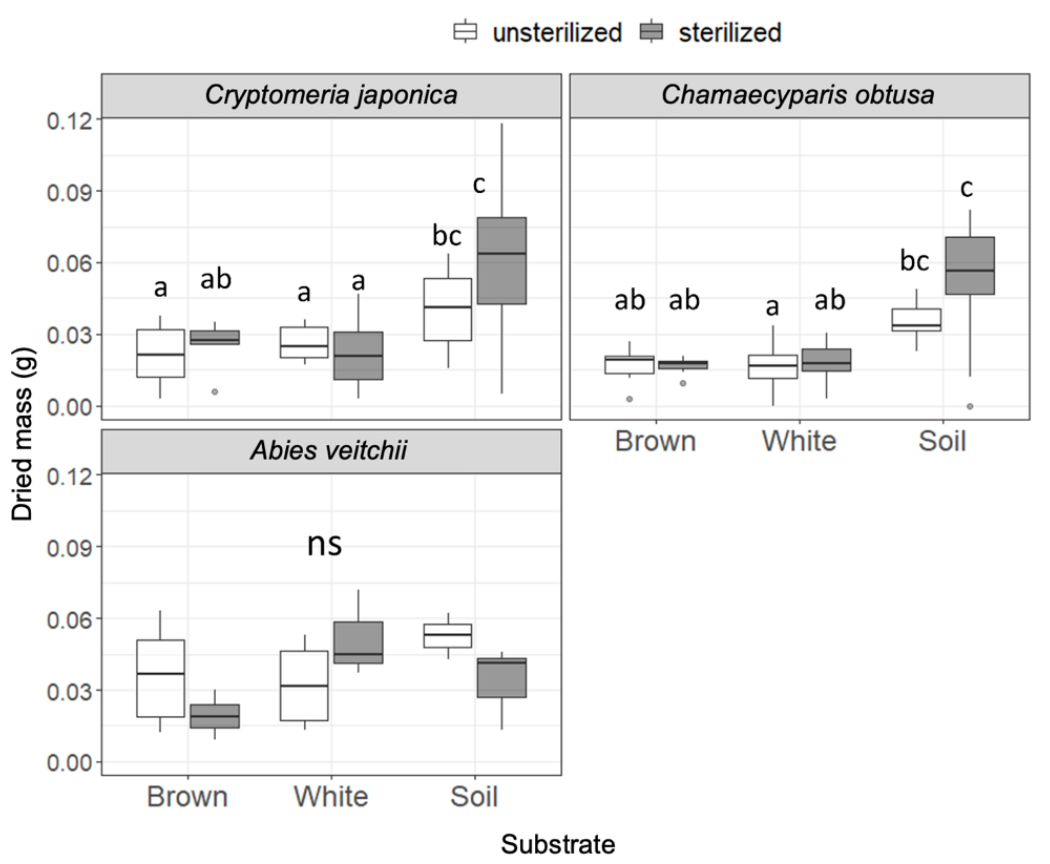
Figure 3. Seedling dry mass of the three tree species after incubation on unsterilized and sterilized substrates (brown rot wood, white rot wood, and soil). Box plots display median, 95% confidence interval, and the minimum and maximum values and points outside the box represent outliers. Dif- ferent letters indicate significant differences among the six substrates ( p < 0.05, Permuted Brunner – Munzel test with Holm adjustment of probability values). ns, not significant. n = 15 except for A. veitchii ( n = 8).